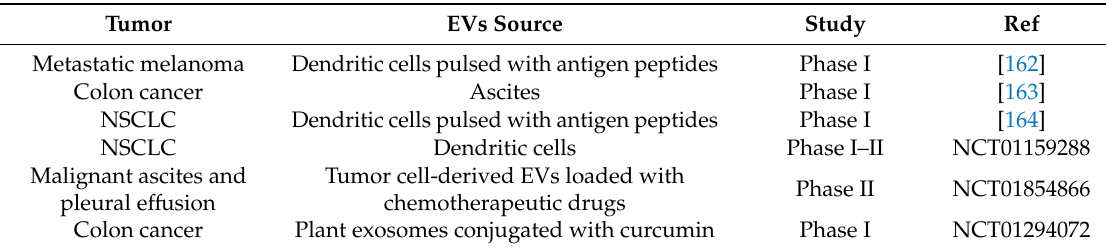
Table 4. Clinical trials investigating extracellular vesicle delivery in cancer